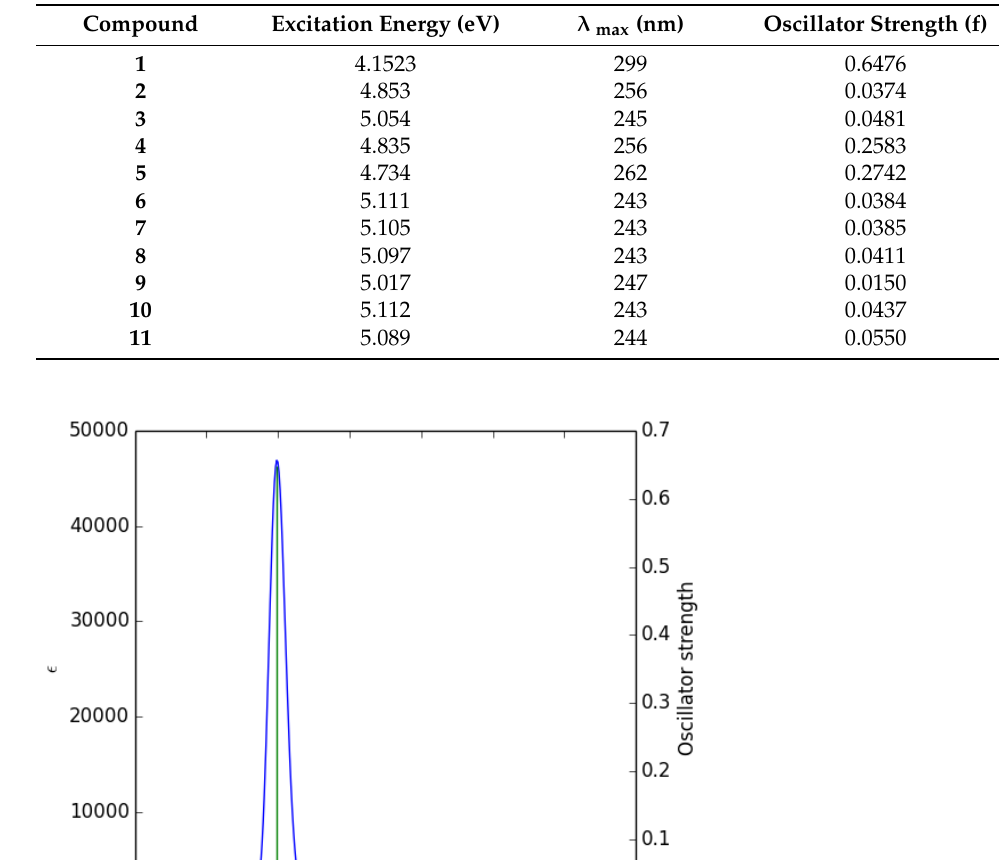
Table 6. Theoretical calculated excitation energies (E), absorption wavelengths (λ max ), and oscillator strengths (f) of all compounds under study.